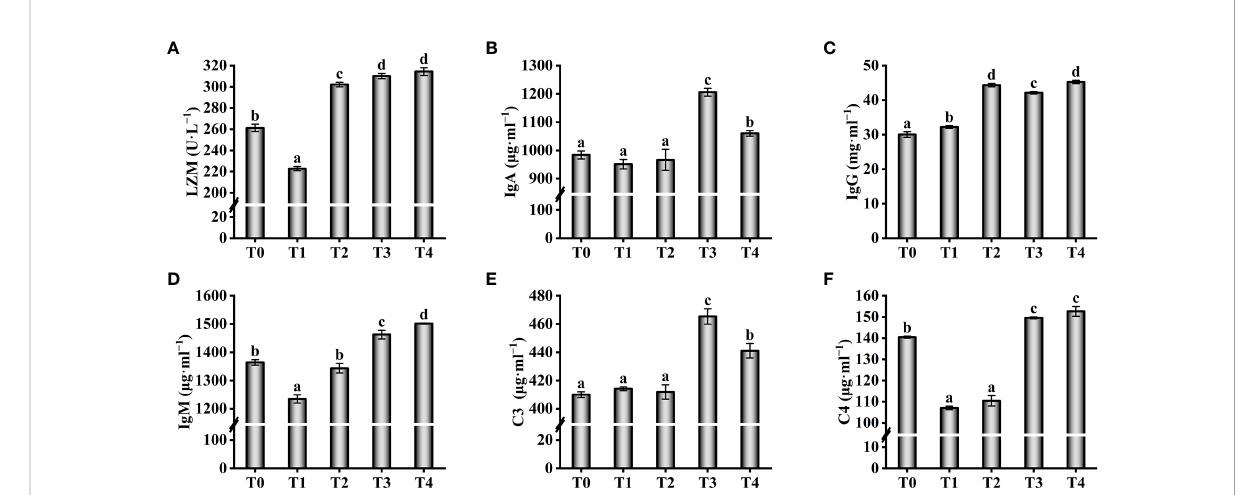
FIGURE 5 Effect of immunological parameters such as LZM (A) , IgA (B) , IgG (C) , IgM (D) , C3 (E) , C4 (F) in the serum of T. ovatus fed diets with different dose taurine supplementation after 8 weeks. Mean values (n = 9) within values in the picture above with different superscripts are signi fi cantly different ( P <